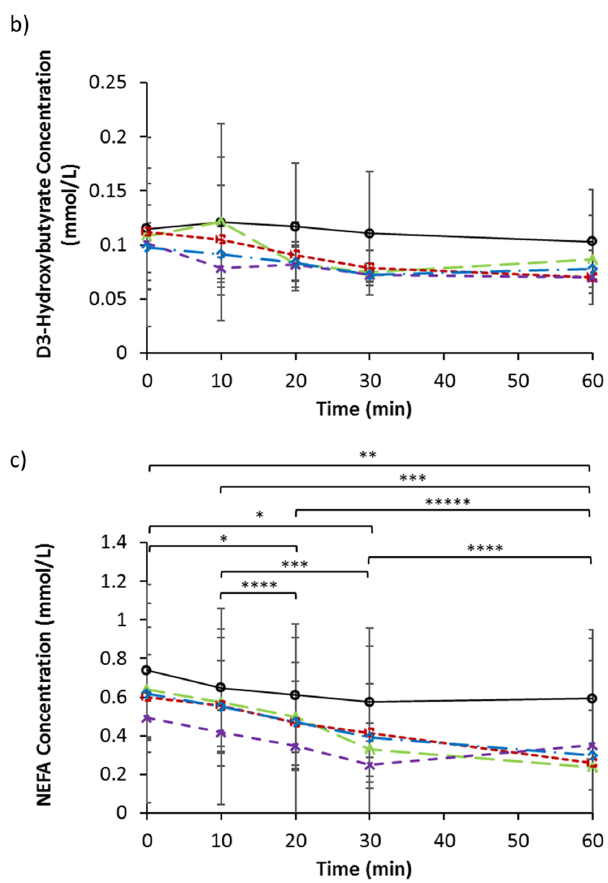
Figure 3. Serum ( a ) triglycerides ( b ) D ‐ 3 hydroxybutyrate and ( c ) non esterified fatty acids (NEFA) concentrations at baseline and following ingestion of 595 mL of water (W), 6% fructose (F), 6% glucose (G), 6% sucrose (S) and 6% combined glucose and fructose (C) solutions. * Decrease from baseline for W, G, and C; ** Decrease from baseline for G and C; *** Decrease from 10 min for G and C; **** Decrease from time ‐ point for G; ***** Decrease from time ‐ point for C. All p < 0.05. Values are mean ± standard deviation.